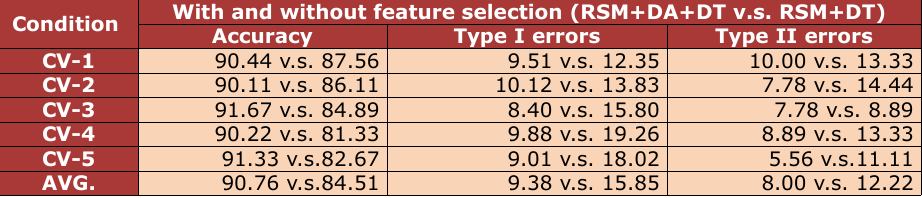
Table 5. The results of scenario 2